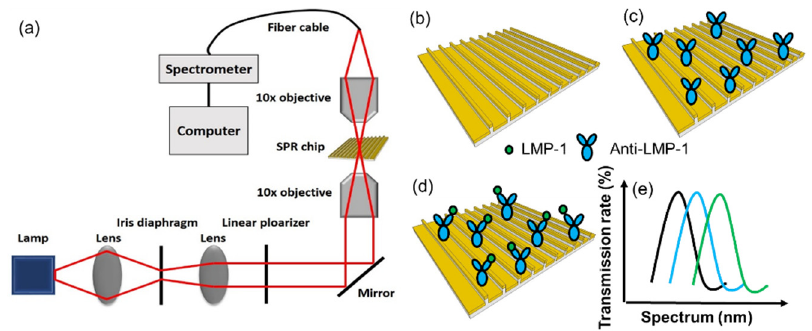
Figure 1. ( a ) Optical setup and ( b – e ) the detection mechanism.